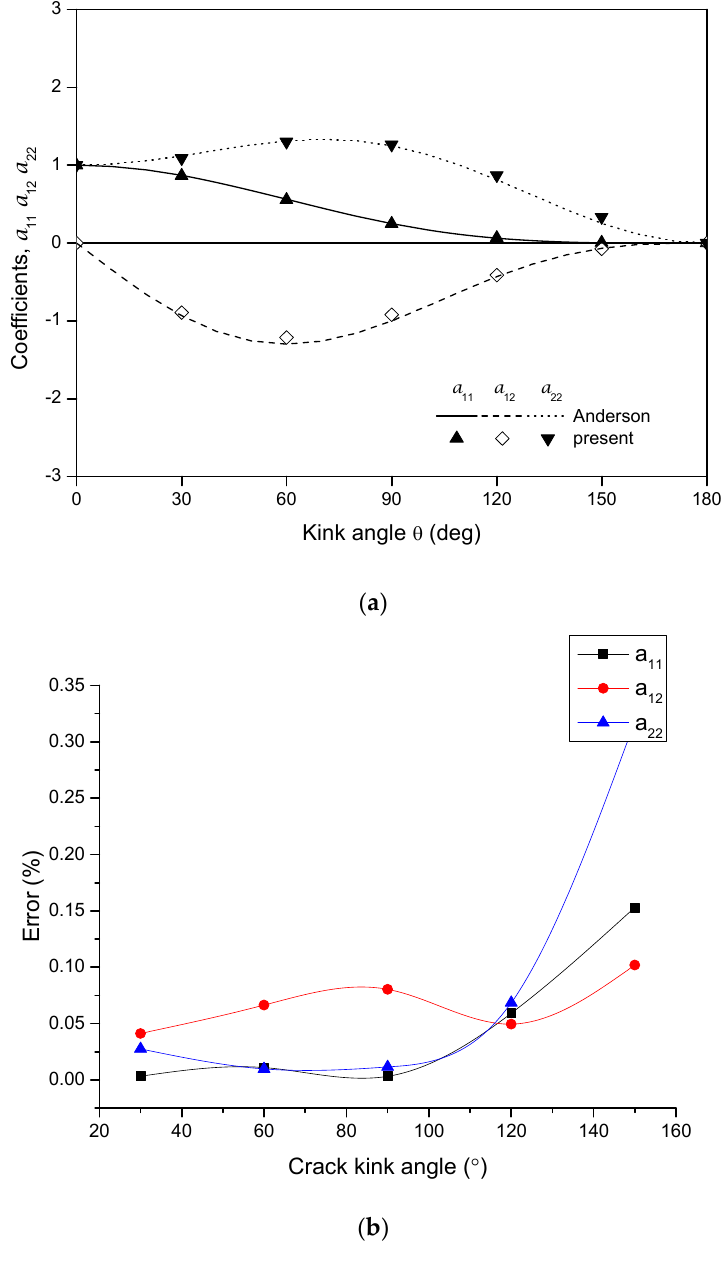
Figure 9. Energy release rate coefficients of the present work compared with Anderson. ( a ) The energy release rate coefficients of the present work compared with Anderson; ( b ) Error.